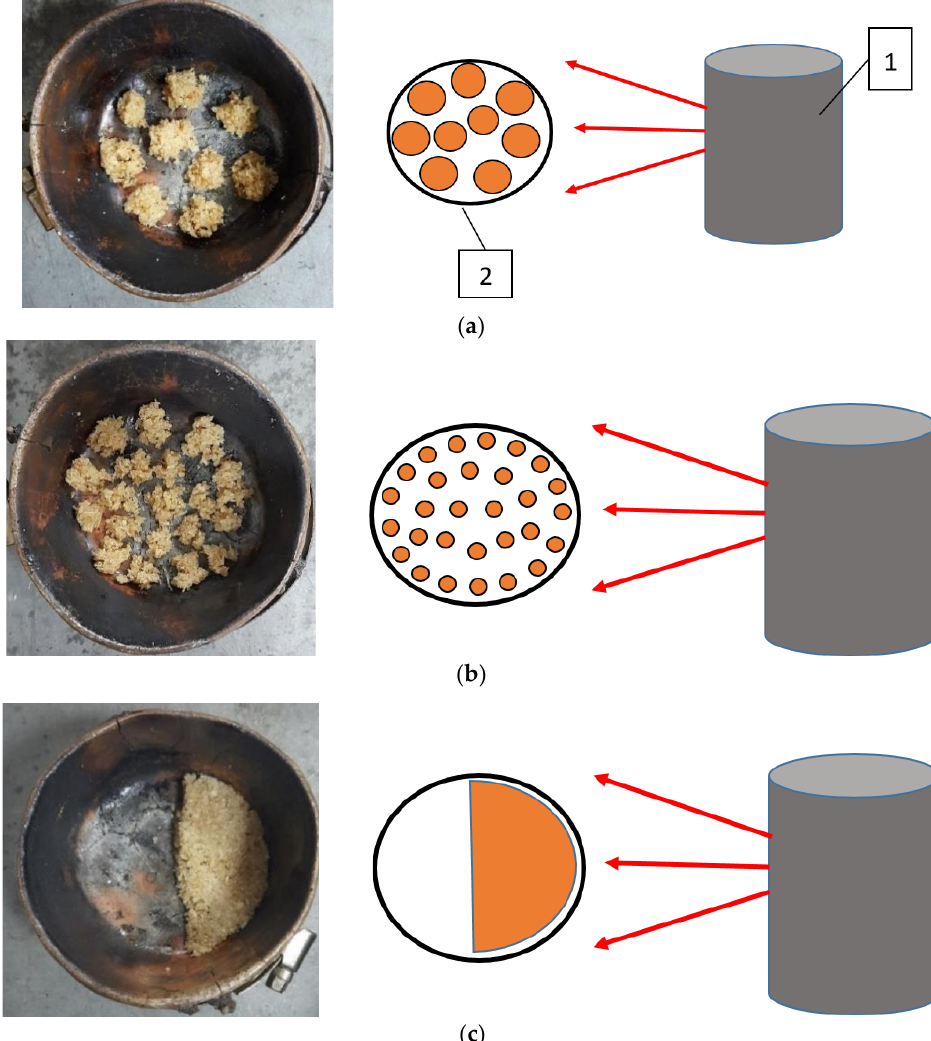
Figure 7. Distribution of the fuel sample in the crucible: a set of large fragments ( a ), a set of small fragments ( b ), on a half of the crucible bottom ( c ).